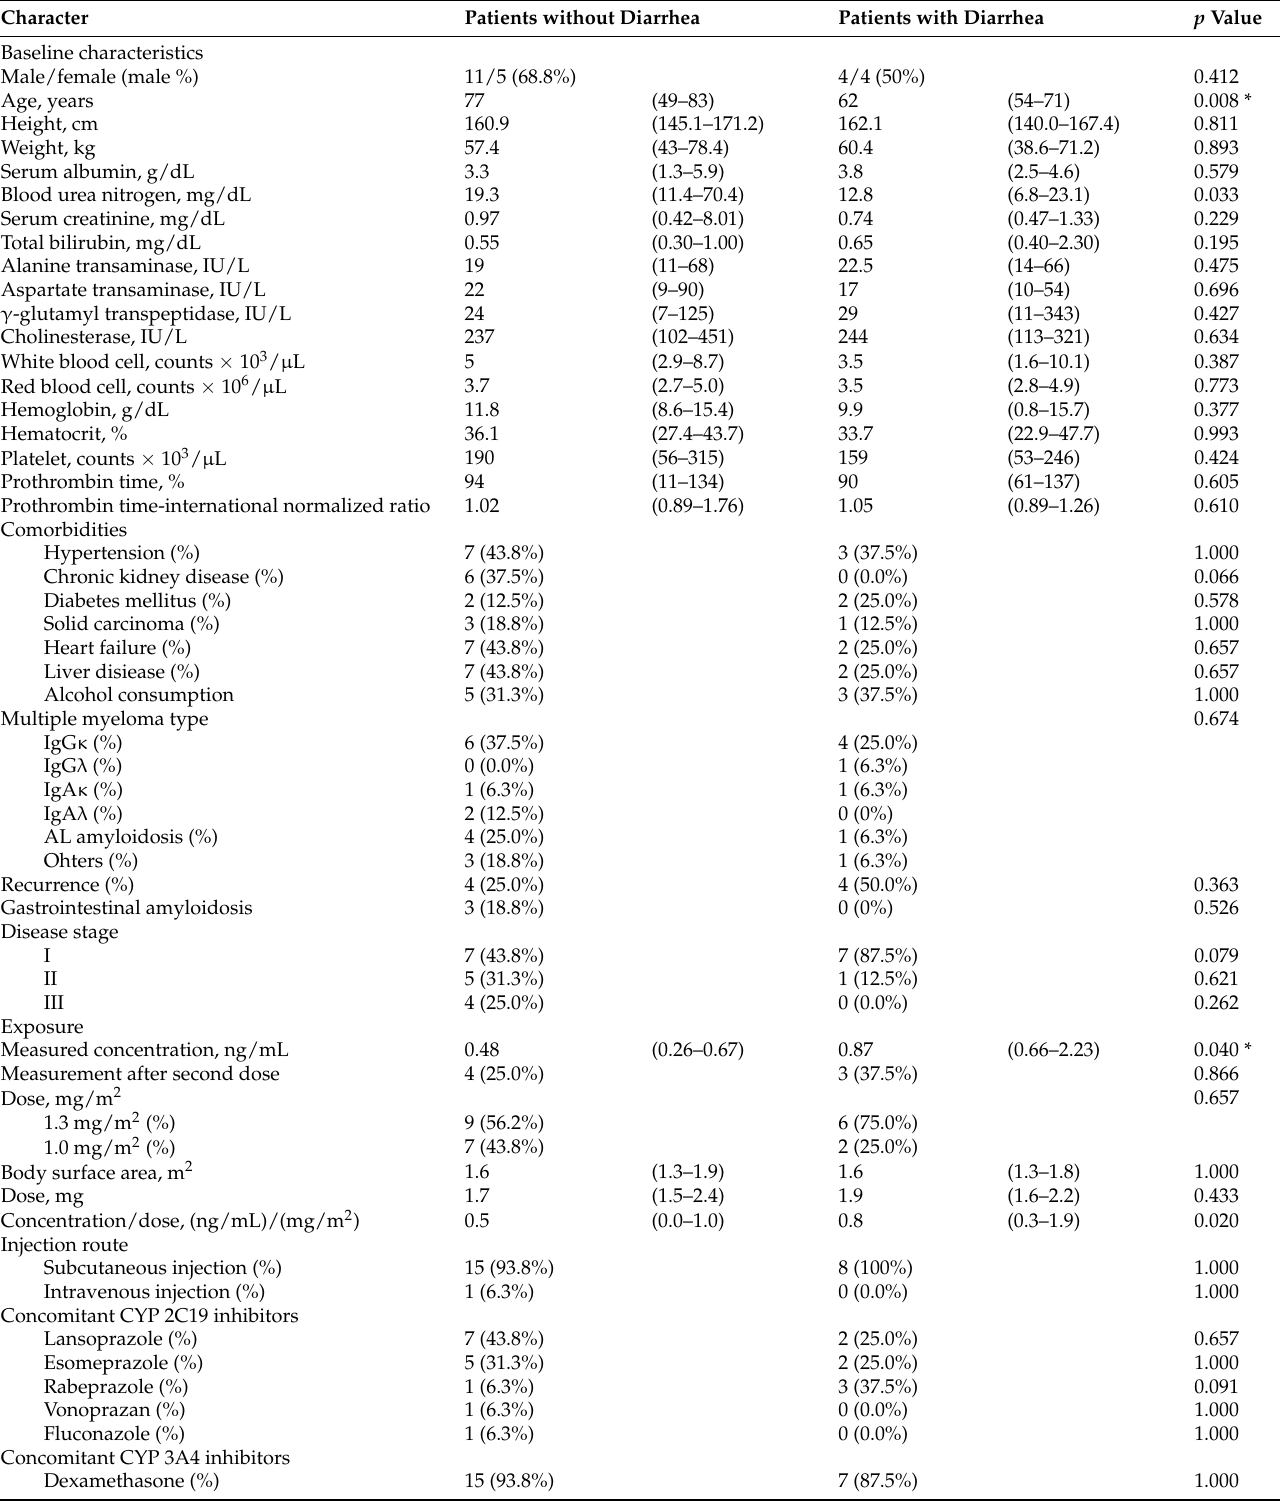
Table 1. Demographics of recruited